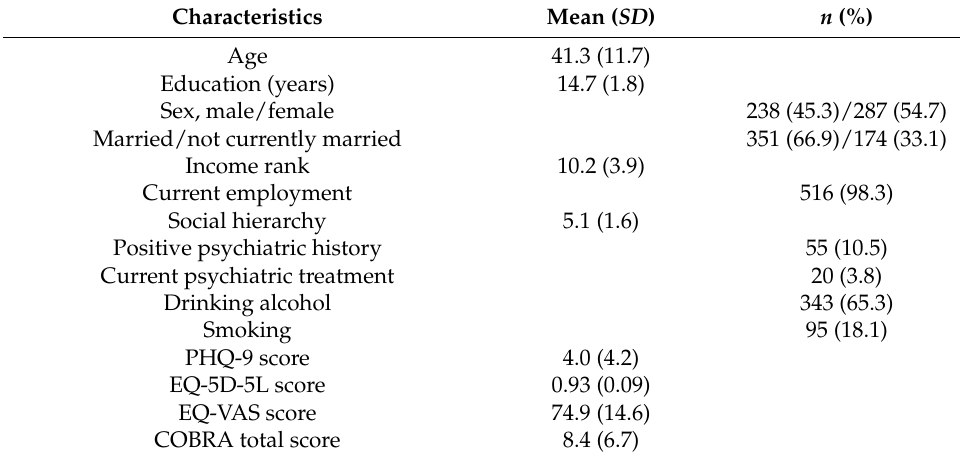
Table 1. Clinical and sociodemographic data ( n =